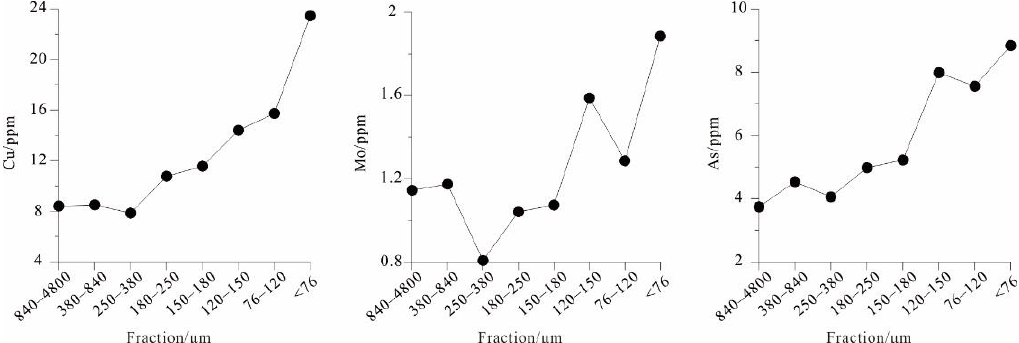
Figure 8. Line chart showing the concentrations of Cu, Mo, and As in different sized fractions of soil